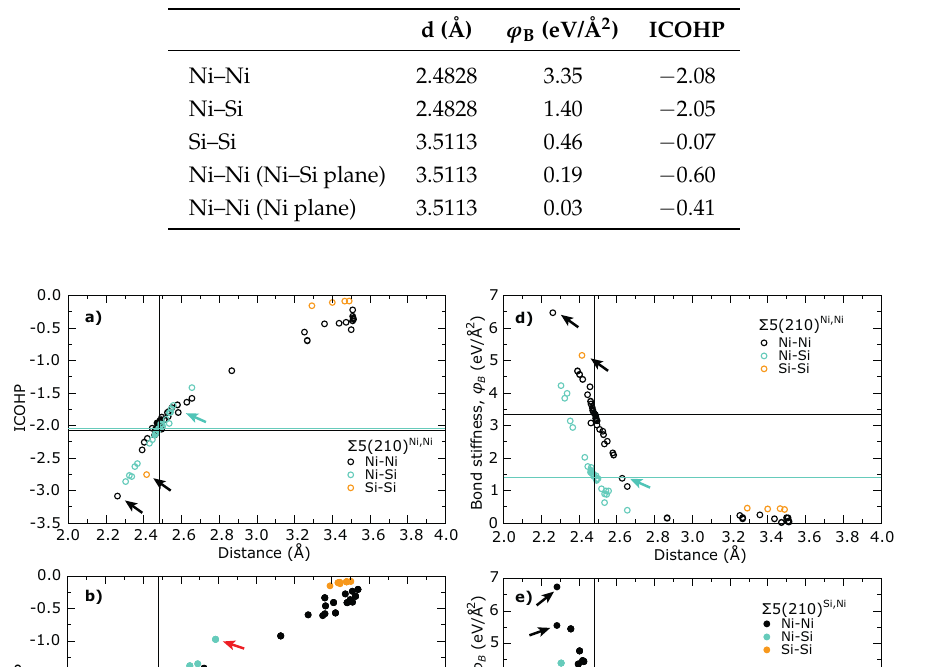
Table 3. Properties of nearest and next nearest neighbor bonds in bulk Ni 3 Si: bond length d , projected force constant ϕ B and integral of COHP up to the Fermi level.